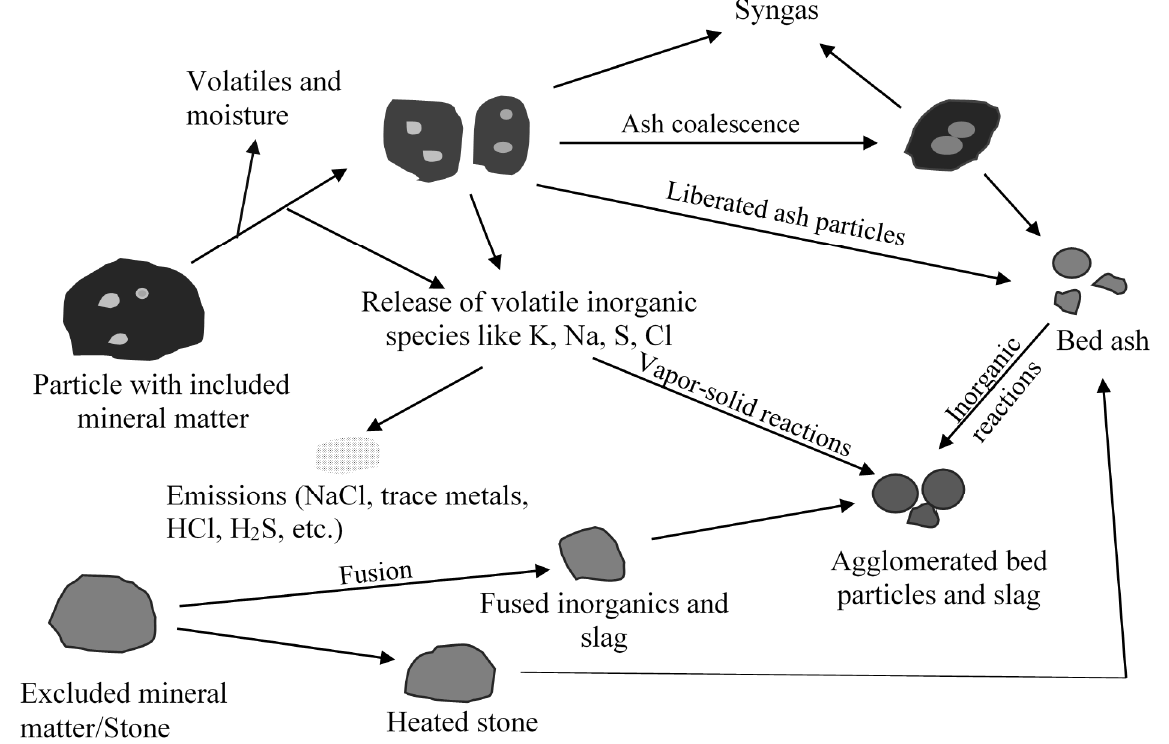
Figure 2. A schematic of summary of mineral matter transformations and formation of agglomerates in a fixed bed